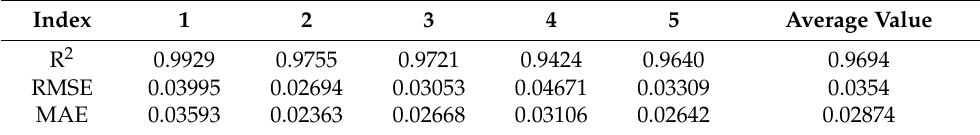
Table 6. Value of evaluation indices of the five-fold cross-validation for the RSM model on sensitivity. Table 7. Value of evaluation indices of the five-fold cross-validation for the RSM model on creep.